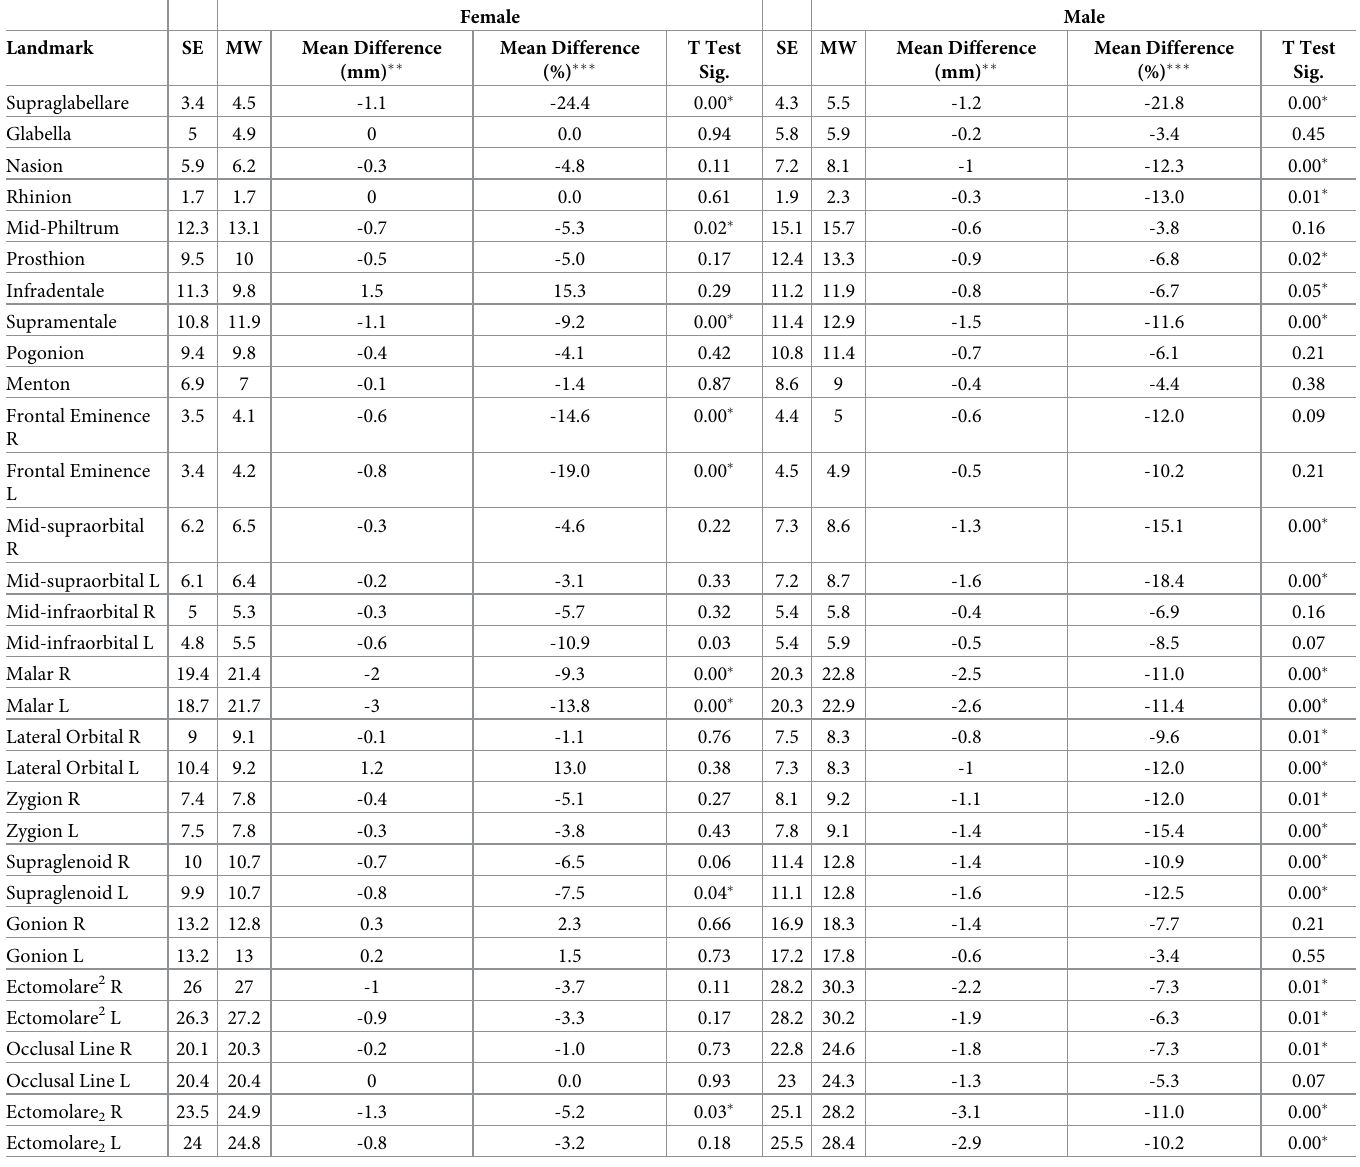
Table 4. FSTT (in millimeters) comparison among SE and MW regions, in both